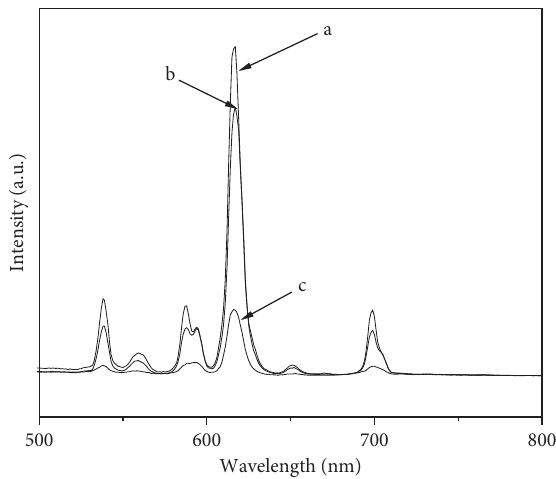
Figure 9: Emission spectra of YVO 3+ produced through 4 :(5%) Eu ultrasonic irradiation with different pH end values: (a) 10.0, (b) 8.0, and (c) 12.0 under the excitation of 280nm at room